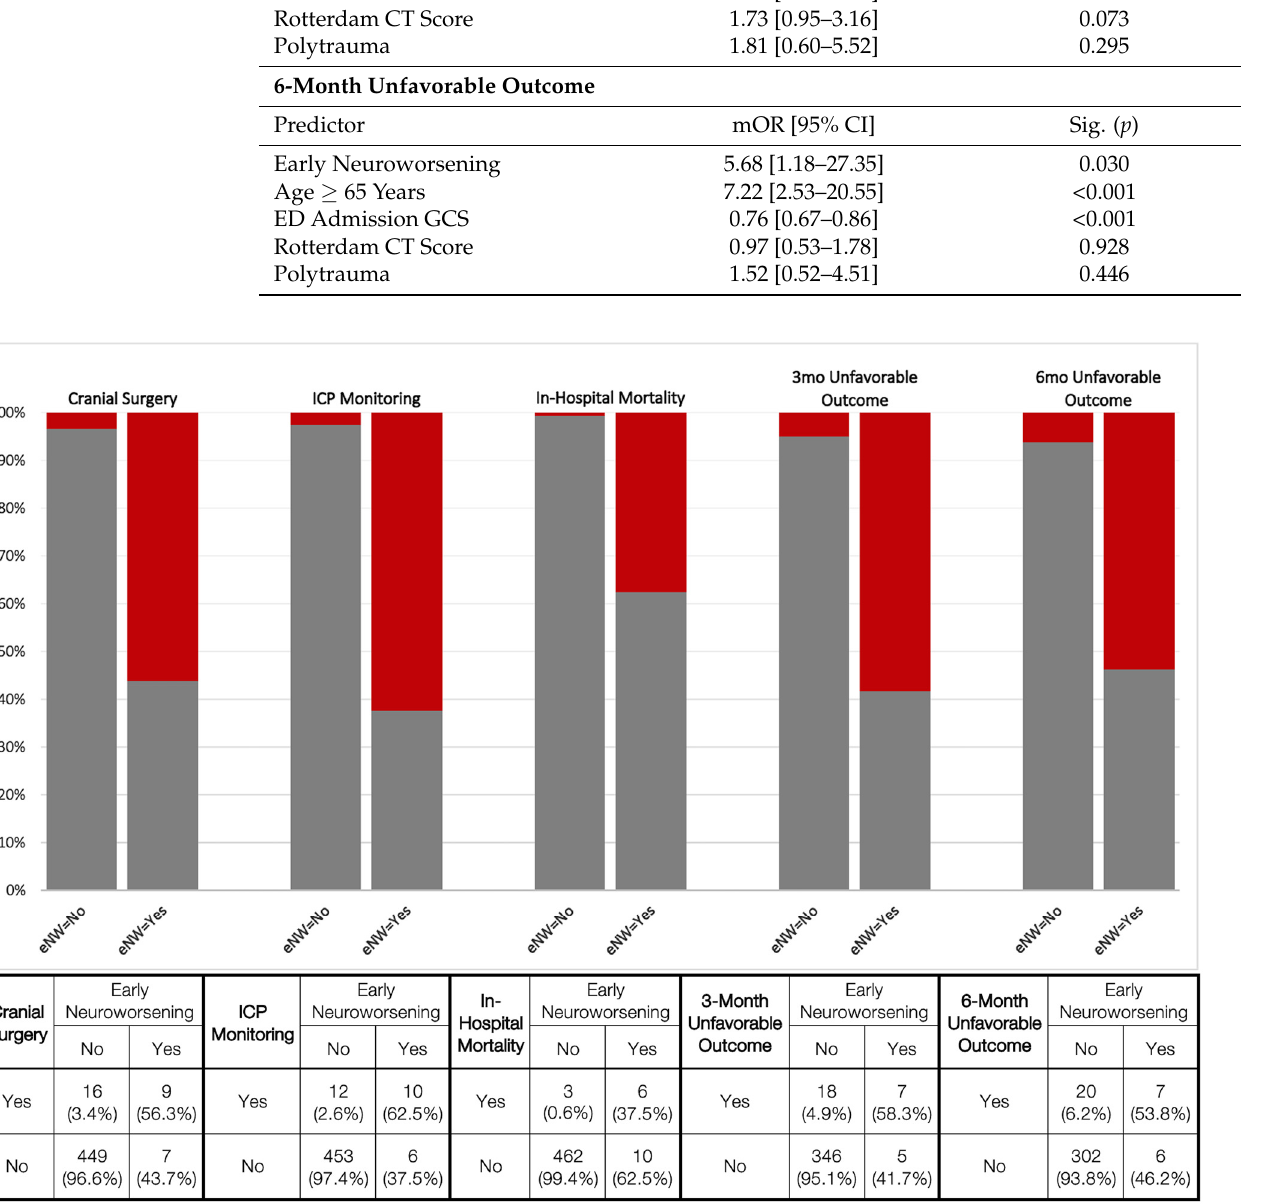
Figure 2. Interventions and outcomes by early neuroworsening. Proportions of presence (red) or absence (gray) of neurosurgical intervention (cranial surgery; ICP monitoring), in-hospital mortal- ity, and 3- and 6-month unfavorable outcome (Glasgow Outcome Scale-Extended score of 1–3) are displayed by early neuroworsening (eNW) status. Column percentages are provided in the table. All comparisons were statistically significant with p < 0.001. eNW = early neuroworsening; ICP = intracranial pressure; mo = month.